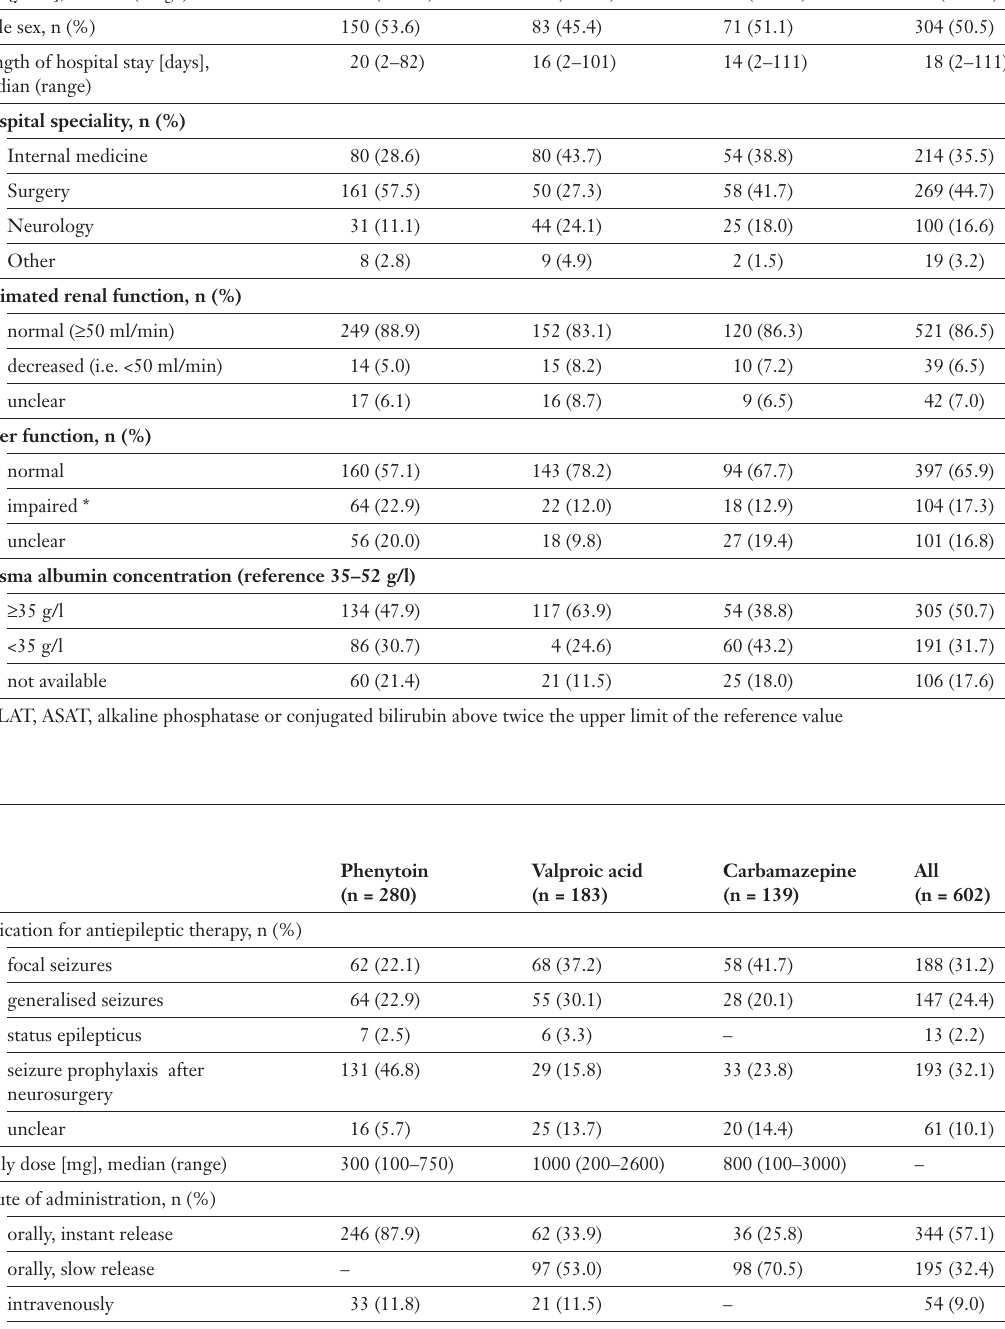
Characteristics of 602 inpatients for whom a drug level determi- nation of phenytoin, carbamazepine or valproic acid was done.